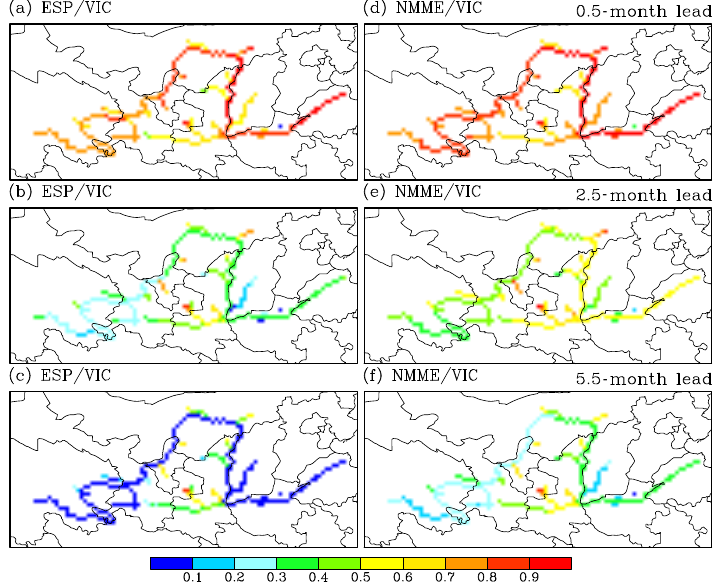
Figure 6. The same as Fig. 5 but for streamflow along the mainstream and major tributaries of the Yellow